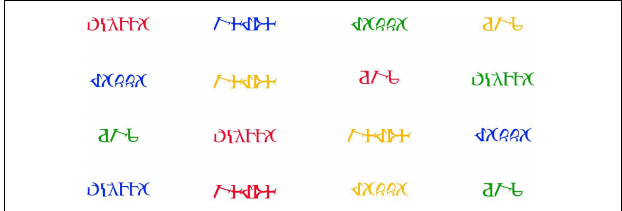
FIGURE 3 | Naming Without Interference (NWoI).